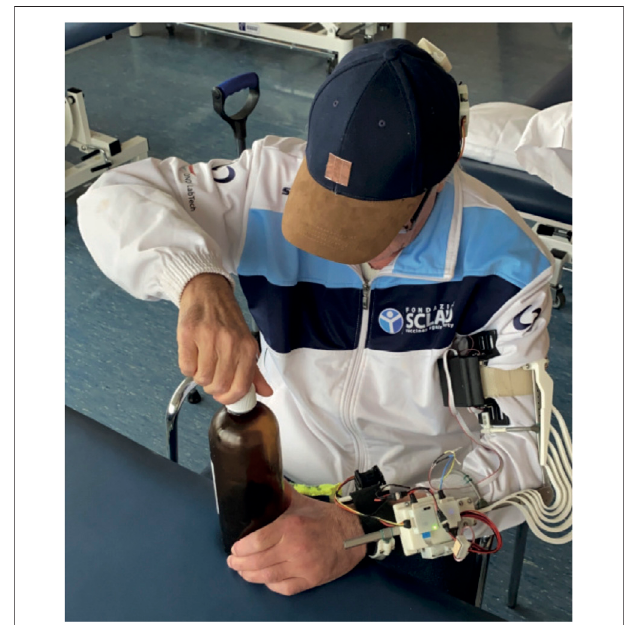
FIGURE8| AstrokepatientopeningabottlewiththehelpoftheSoftPro wearable